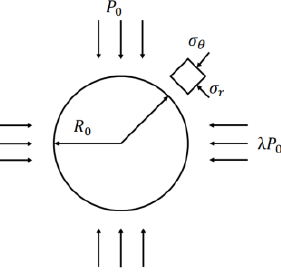
Figure 2. Mechanical model induced by shaft sinking under unequal confining pressures. ( R 0 is shaft radius; P 0 is the vertical stress of the shaft; 𝜎 𝜃 is tangential stress; 𝜎 𝑟 is radial stress; λ is the ratio of horizontal stress.).